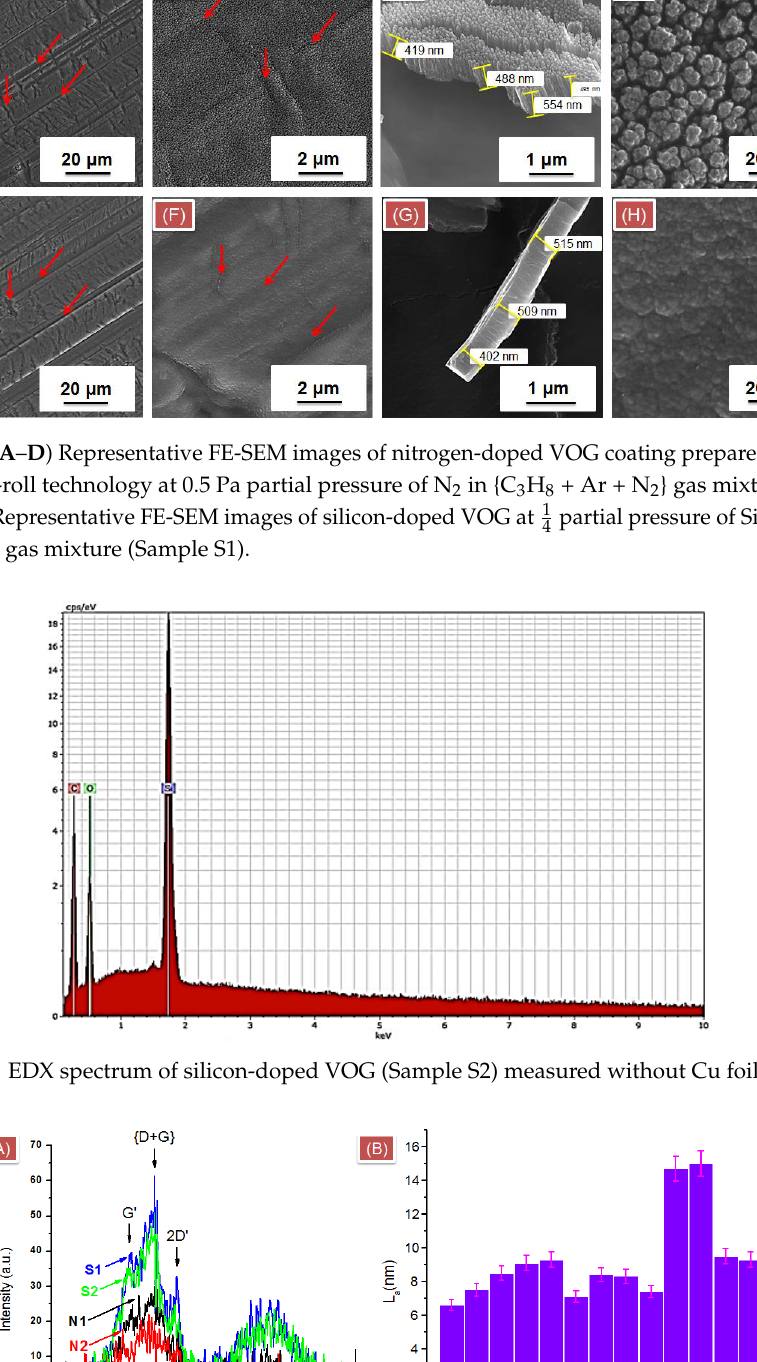
Figure A10. ( A ) Averaged Raman spectra of nitrogen-doped (Samples N1 and N2) and silicon-doped (Samples S1 and S2) VOG coatings obtained at 473 nm excitation wavelength (10 s of integration time and 100× objective). ( B ) Calculated values of nanographite size ( L a , nm) of all types of VOG coatings by using the IntD/IntG ratio of most prominent D and G Raman bands. The numbers (1–9), N1 and N2, S1 and S2 along the x axis indicate VOG samples.